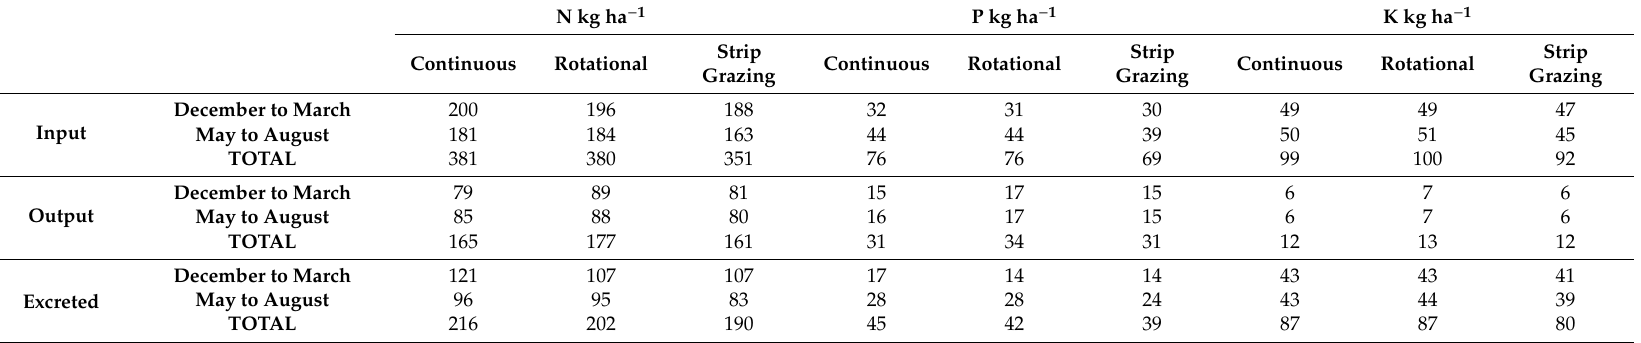
Table 4. Balance of Nitrogen, Phosphorus and Potassium (kg ha − 1 ), in tall fescue paddocks managed with growing-finishing pigs. N kg ha − 1 P kg ha − 1 K kg ha − 1 Strip Strip Strip Continuous Rotational Continuous Rotational Continuous Rotational Grazing Grazing Grazing